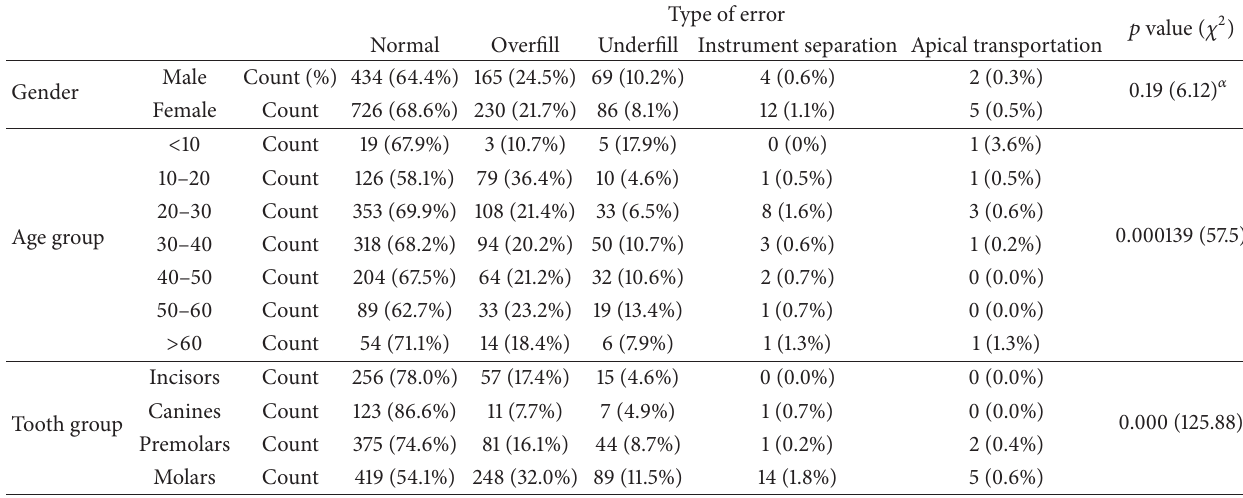
Table 1: Distribution of age, gender, and tooth group with endodontic treatment and type of procedural error.